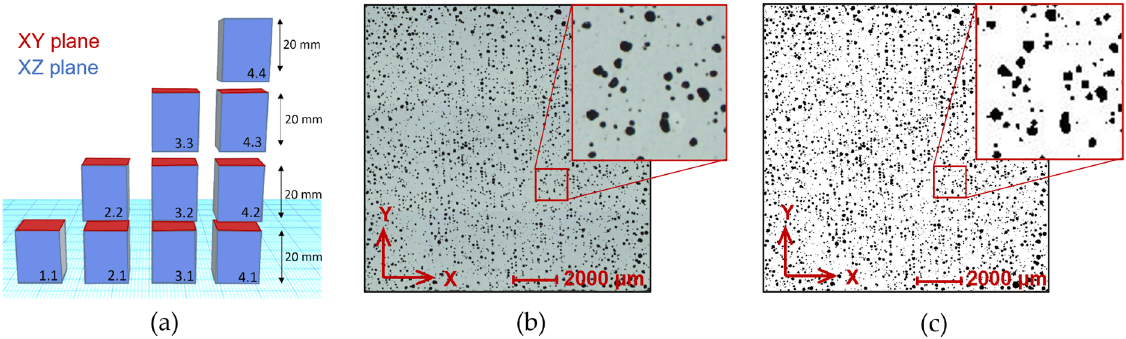
Figure 3. ( a ) Bulk sample divided into the sections for metallographic processing, ( b ) image of porosity in the sample after metallographic processing and ( c ) image from ImageJ software for evaluation of relative density.